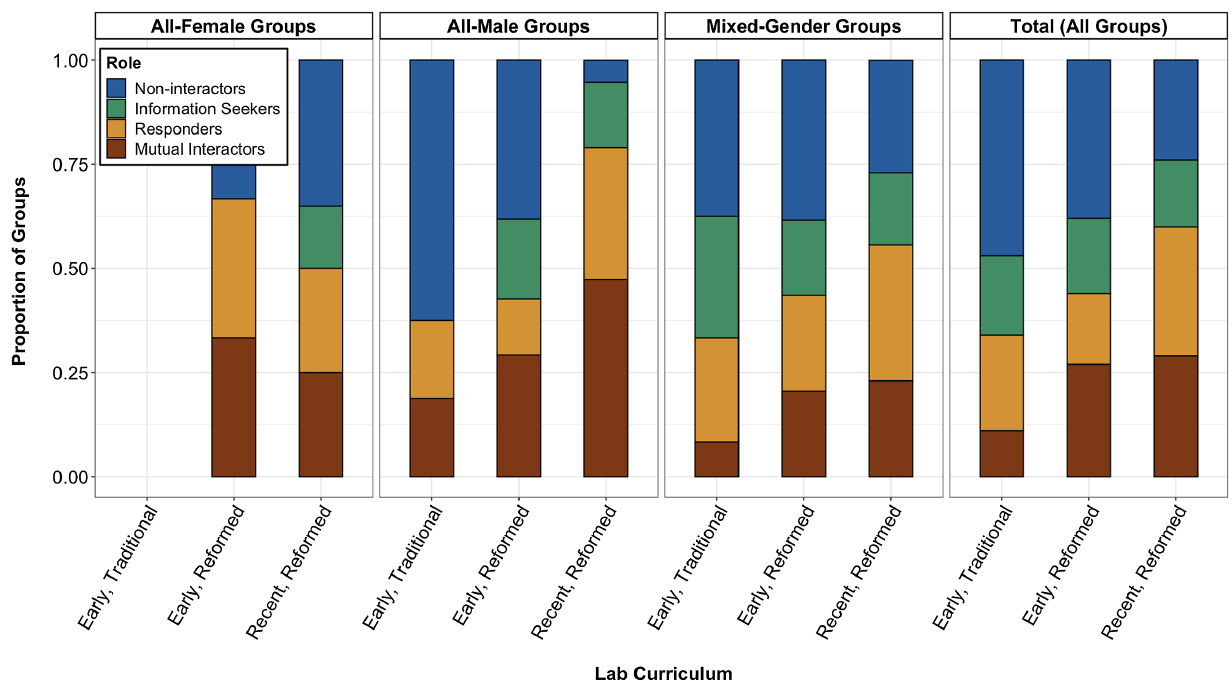
FIG. 6. Stacked bar charts of the proportion of groups of each gender composition and in total that take on each social role within each lab curriculum. The early, traditional lab contained no all-female